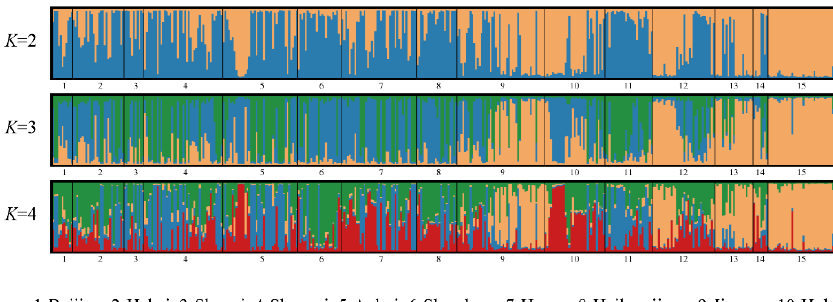
Figure 2. Scatterplot from discriminant analysis of principal components (DAPC) of the first two principal components discriminating Pt populations by regions. Points represent individual obser- vations. Lines and shapes represent population membership.